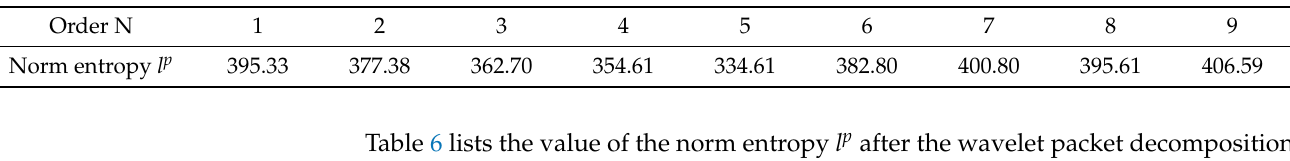
Figure 7. Focused signals under nine operating conditions.